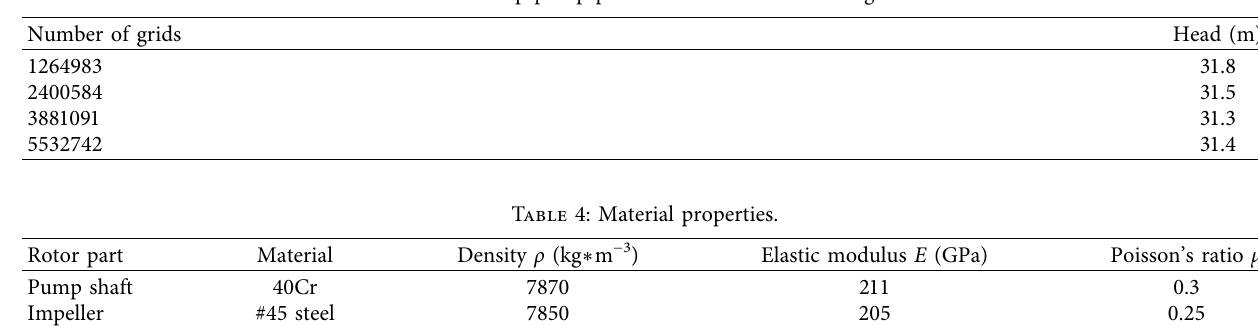
Figure 4: Solid domain mesh. Table 3: Predicted sump pump performance under different grid